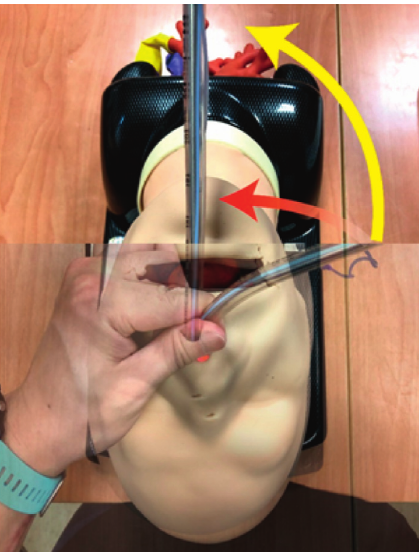
Figure 3: After the tip of the endotracheal tube is inserted into the selected nostril, 90-degree rotation (red arrow) and elevation (yellow arrow) of the Trachway stylet at the same time to midline make the curve to fit the anatomy curve of the nasopharynx and oropharynx.